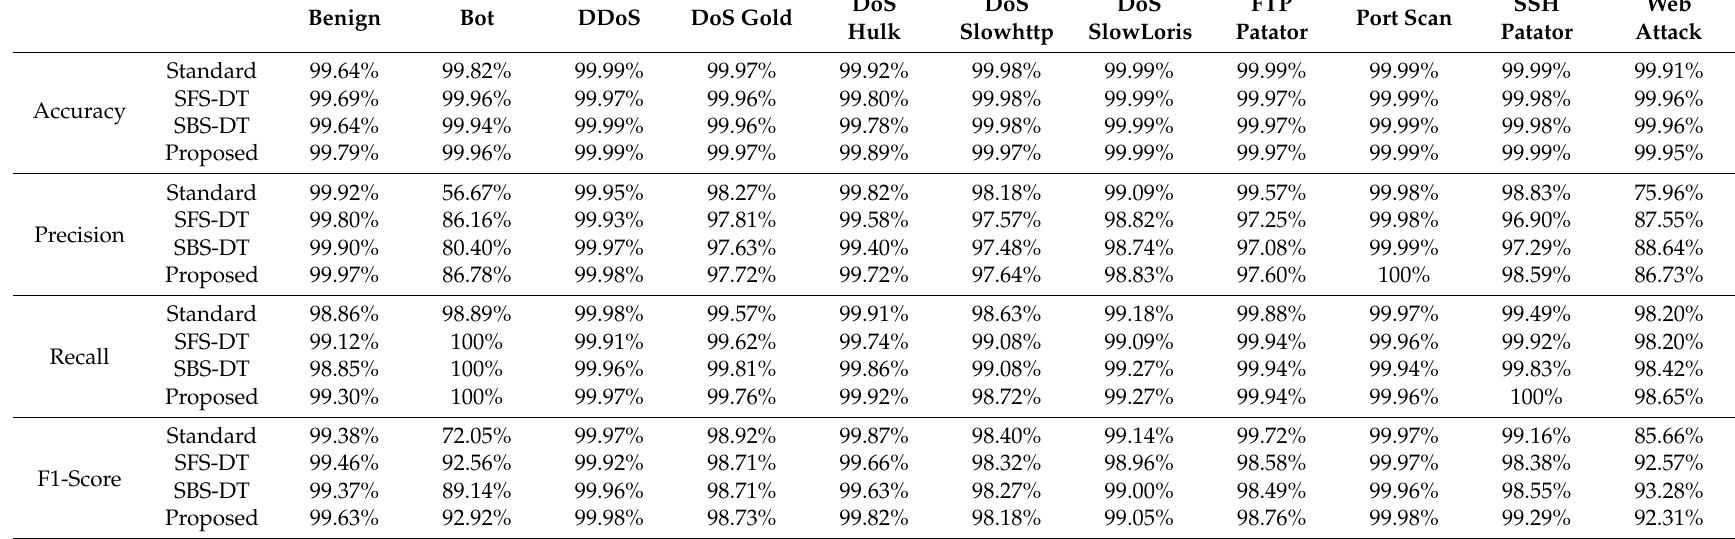
Table 9. Class detection based on each feature selection method for the CIC-IDS 2017